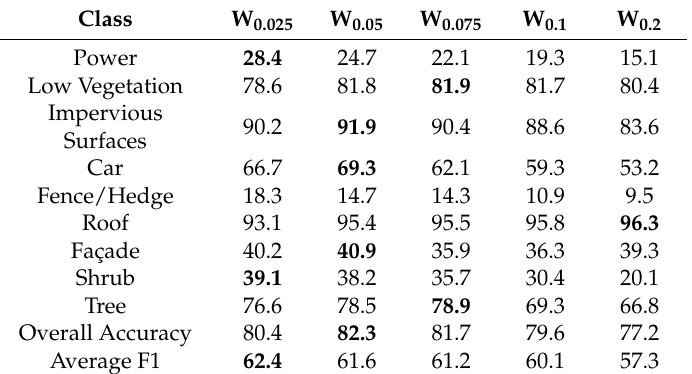
Table 3. The recall value, the overall accuracy of each class and the average F1 value for different cell widths in (%). Bold numbers show the highest values within different features.